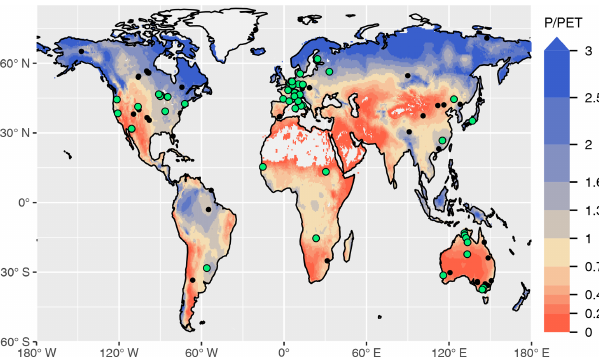
Figure 1. Overview of sites selected for model calibration (green dots) and evaluation (black dots). All sites and additional informa- tion are listed in Table A1. The colour key of the map represents aridity, quantified as the ratio of precipitation over potential evapo- transpiration from Greve et al.